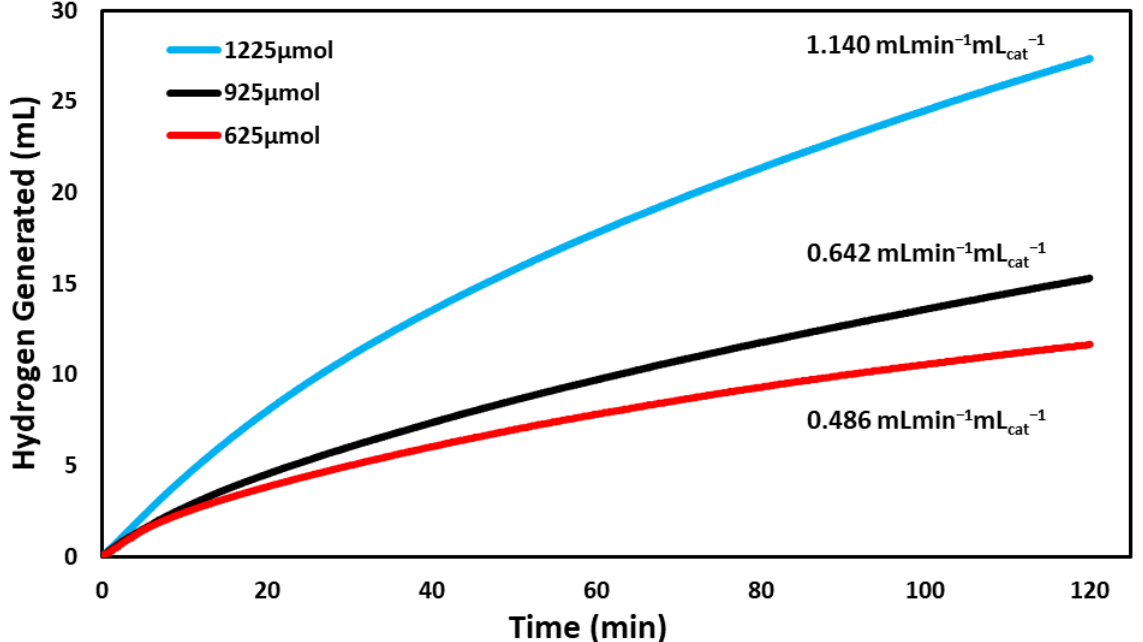
Figure 6. Comparison of the volume of hydrogen gas generated versus time by the hydrolysis reaction of three different concentrations of sodium borohydride (625 µmoles, 925 µmoles, 1225 µmoles) as catalyzed by BCD−AuNPs. The reactions were run at 295 K and at pH 7 for roughly 120 min.